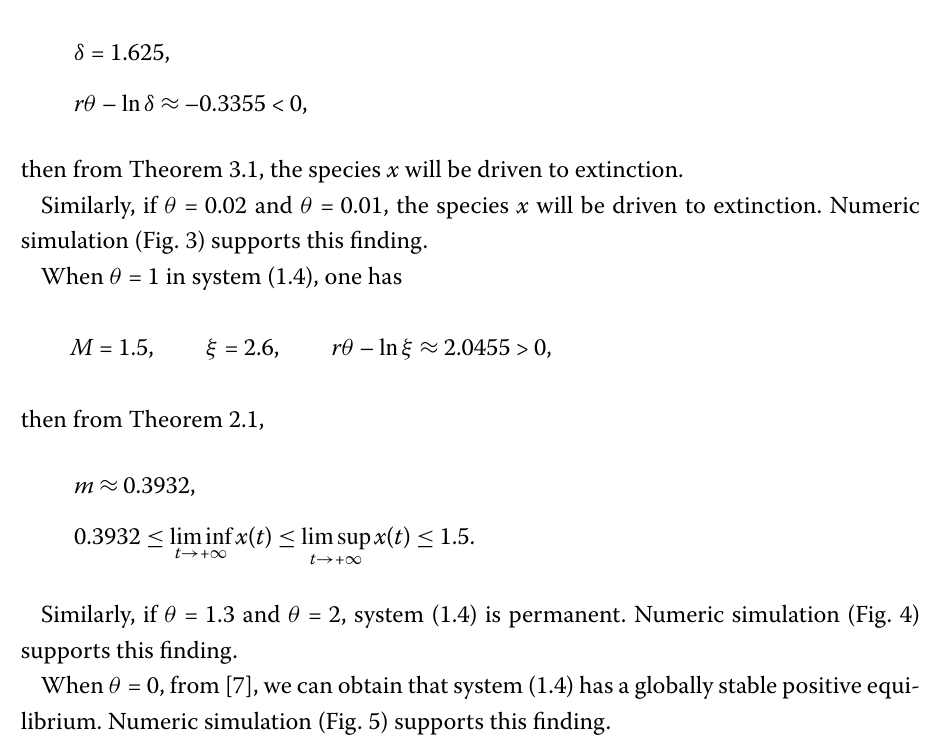
then, from Theorem 2.1, system (1.4) is permanent. That is, the period of harvesting is one of the essential factors leading to the extinction or permanence of the